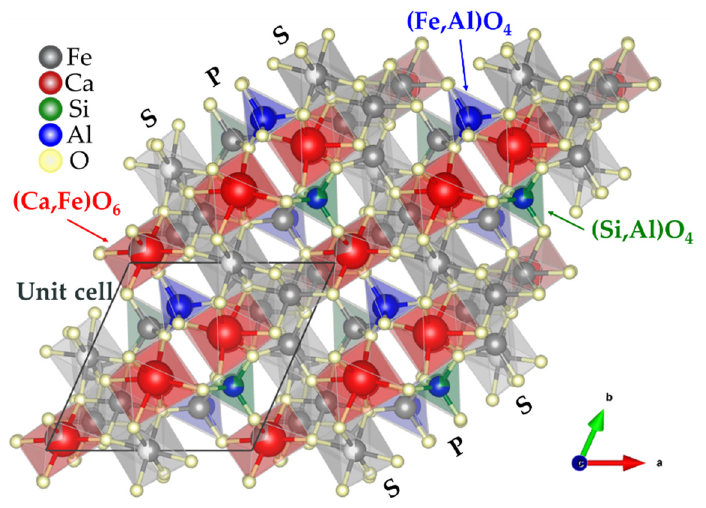
Figure 10. Schematic of the crystal structure of SFCA in the polyhedral model (with the ball and stick model) indicating the sequence of spinel (S) and pyroxene (P), and the atom substitution position of the tetrahedral ((Si, Al)O 4 , (Fe, Al)O 4 ) and octahedral ((Ca, Fe)O 6 ) sites according to Table 7. Table 7. Atomic coordinates and occupancy values for SFCA reported by Hamilton, Takayama et al. Table 6. Main parameters of the crystal structure of SFCA [17] (ICDD: 01-080-0850). and Park et al.